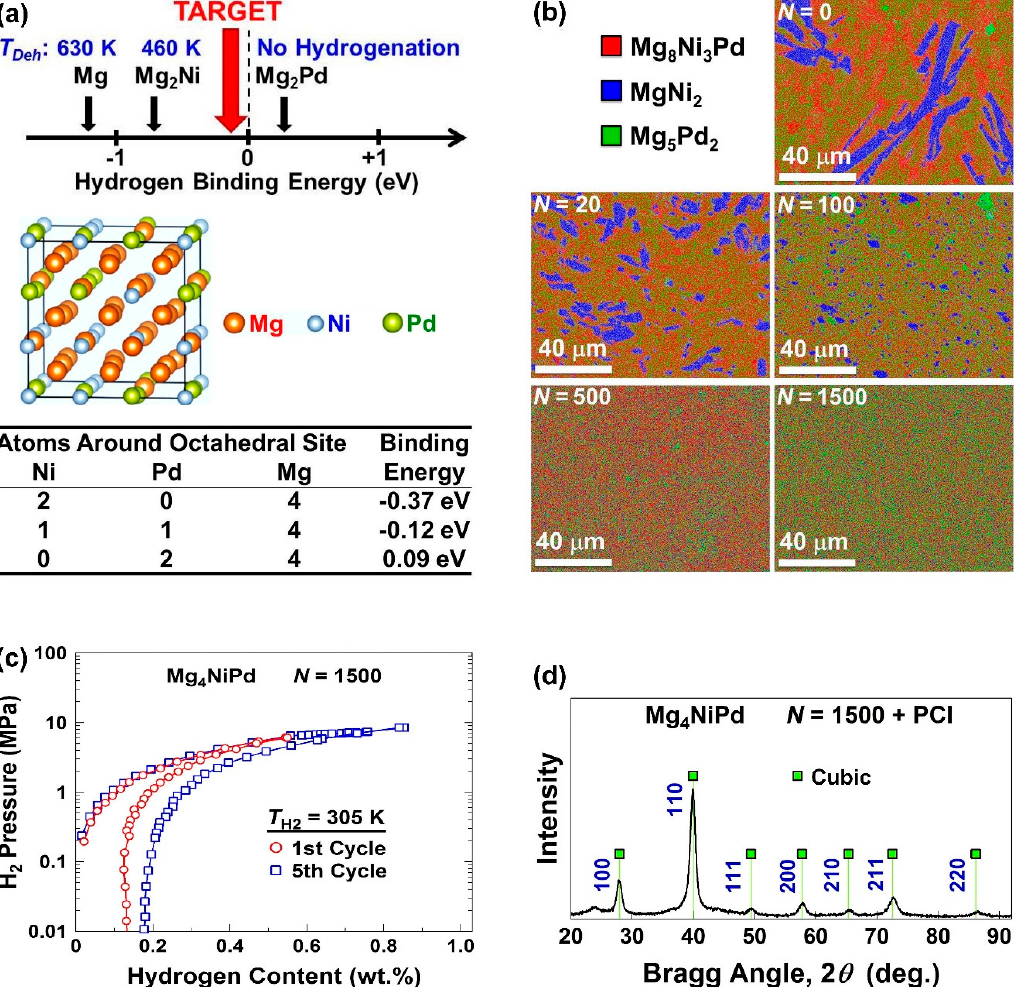
Figure 7. Hydrogen storage at room temperature in magnesium alloy designed by binding-energy engineering any synthesized by ultra-SPD. ( a ) Concept of binding-energy engineering used to de- sign Mg 4 NiPd with appropriate binding energy at 1Ni-1Pd-4Mg octahedral sites. ( b ) Elemental mapping of Mg 4 NiPd before ( N = 0) and after HPT processing for N = 20, 100, 500 and 1500 rotations. ( c ) Pressure-composition isotherms and ( d ) X-ray diffraction profile after five-cycle hydrogena- tion/dehydrogenation for Mg 4 NiPd synthesized by ultra-SPD via 1500 HPT turns